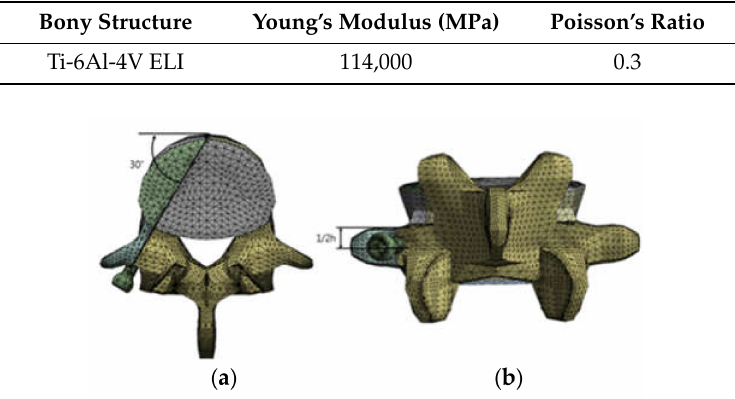
Table 4. Material properties of the pedicle screw.